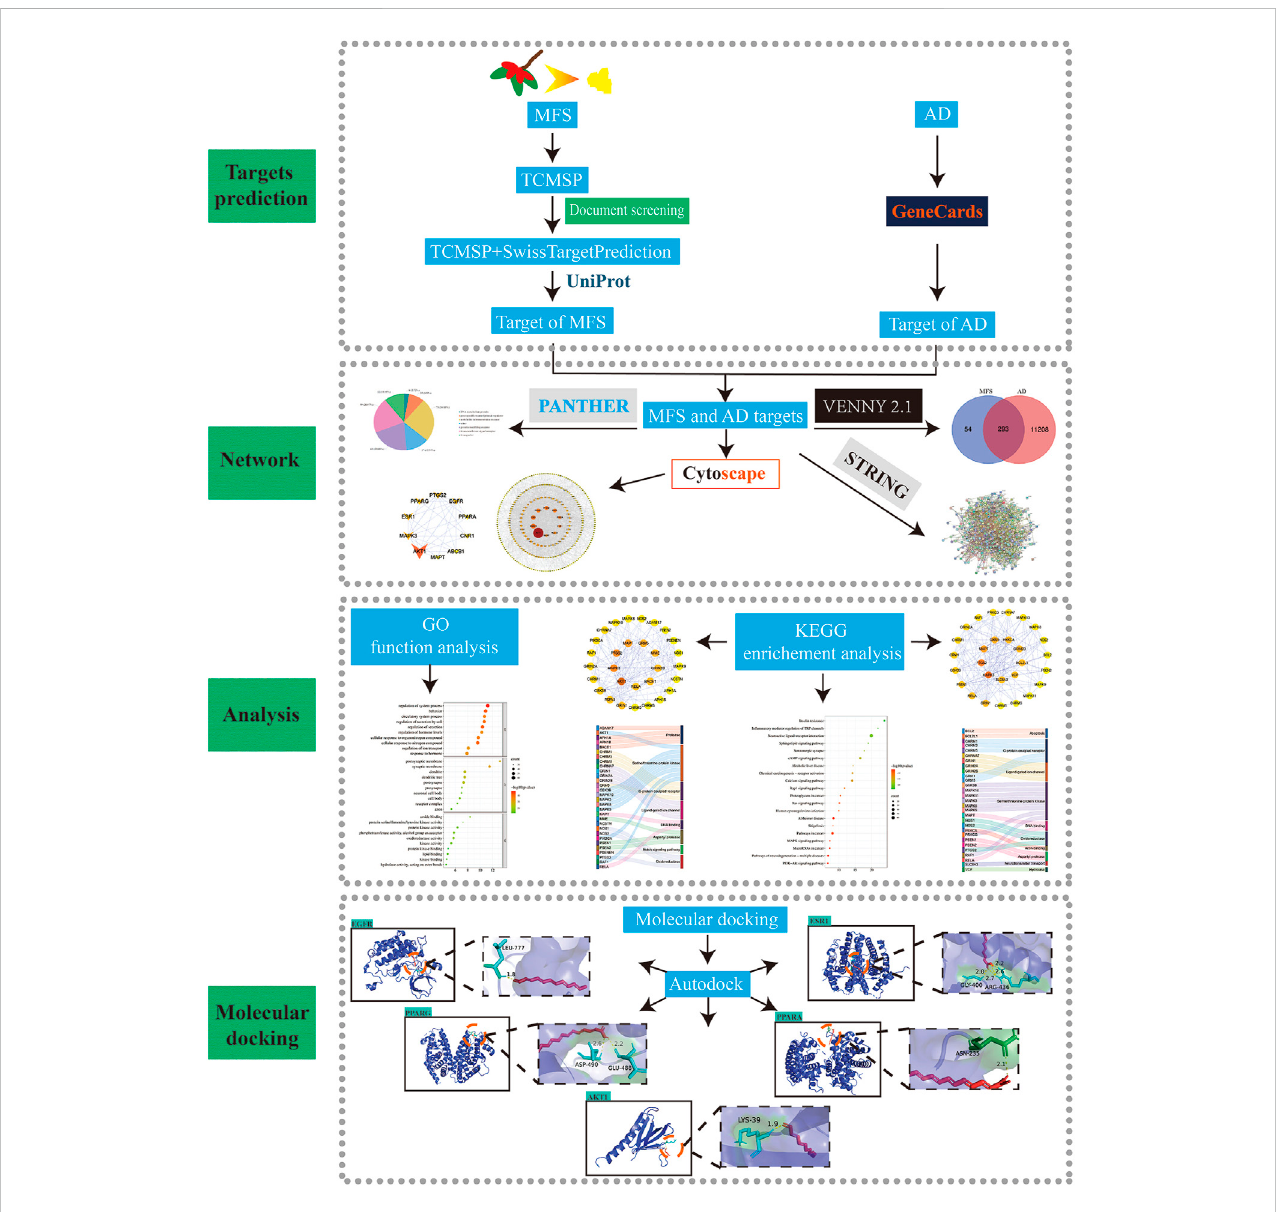
FIGURE 4 Flow chart of study design. (MFS, miracle fruit seed; AD, Alzheimer ’ s